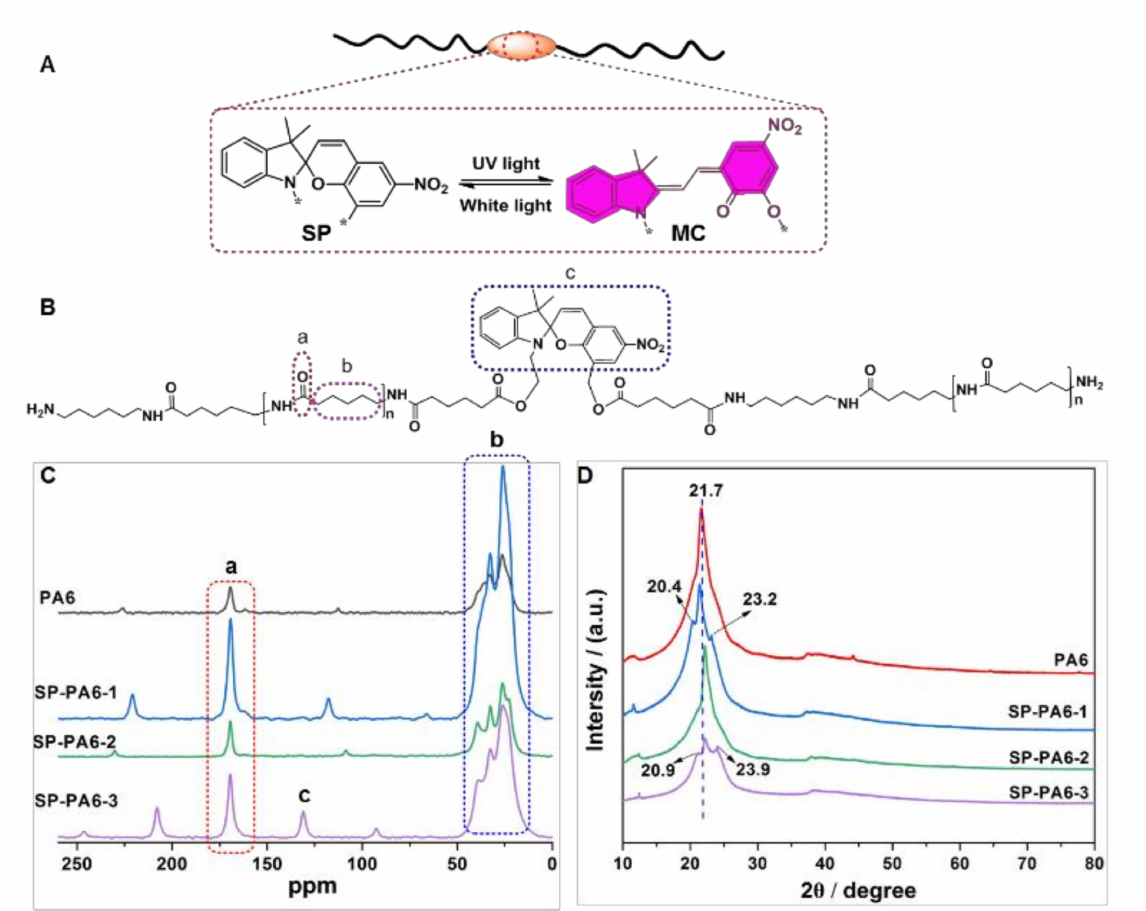
Figure 3. ( A ) The scheme of photochromic PA6 and photochromic mechanism. ( B ) The chemical formula of SP-modified PA6. ( C ) 13 C NMR spectra and ( D ) XRD profiles of PA6 and SP-modified PA6